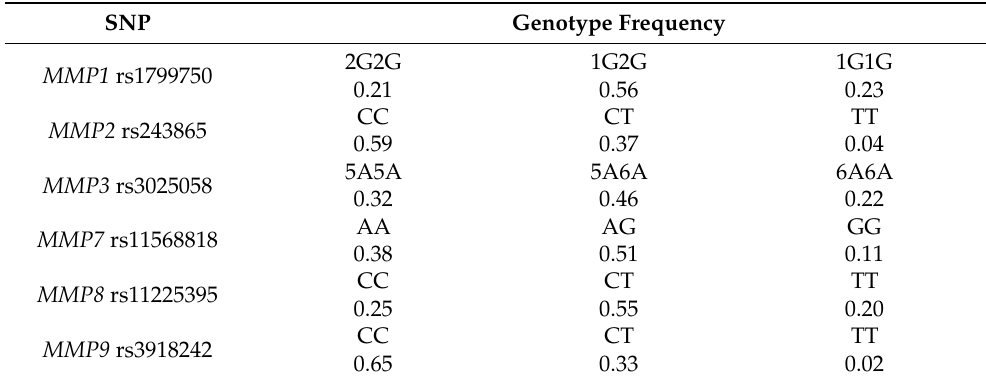
Table 3. Genotypes distribution of MMPs polymorphisms in the study group ( n = 100).